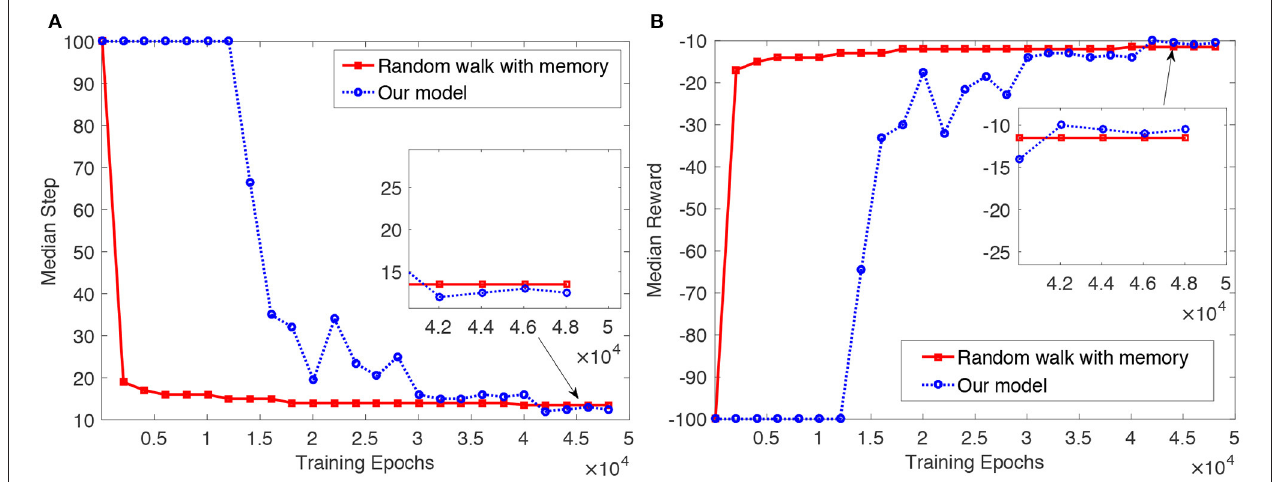
FIGURE 6 | Results of the articulated agent reaching a goal position [surface = 3, x = 1, y = 2] on a 2 articulated goal-oriented learning model over 30 tests with different random seeds. For one epoch in every test, if the current exploration trajectory is greater than its remembered shortest trajectory, we let the remembered shortest trajectory be its current exploration trajectory. To smooth the figure, we show the result every 2,000 epochs. (A) Median step per epoch over the 30 tests. (B) Median reward per epoch over the 30